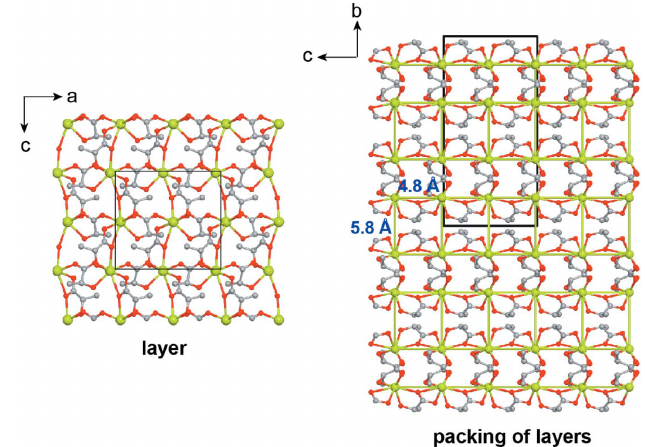
Figure 2 Left: formation of polymeric layers extending parallel to (010); right: bands of (4,4) grids between Cd nodes extending parallel to [001]. H atoms have been omitted for clarity.